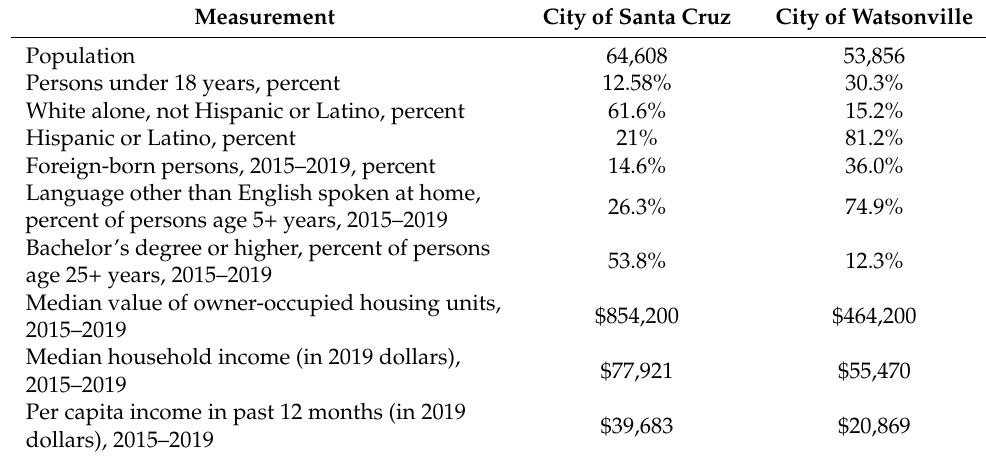
Table 1. Demographic comparison of the two major cities in Santa Cruz County. Source U.S. Census Data